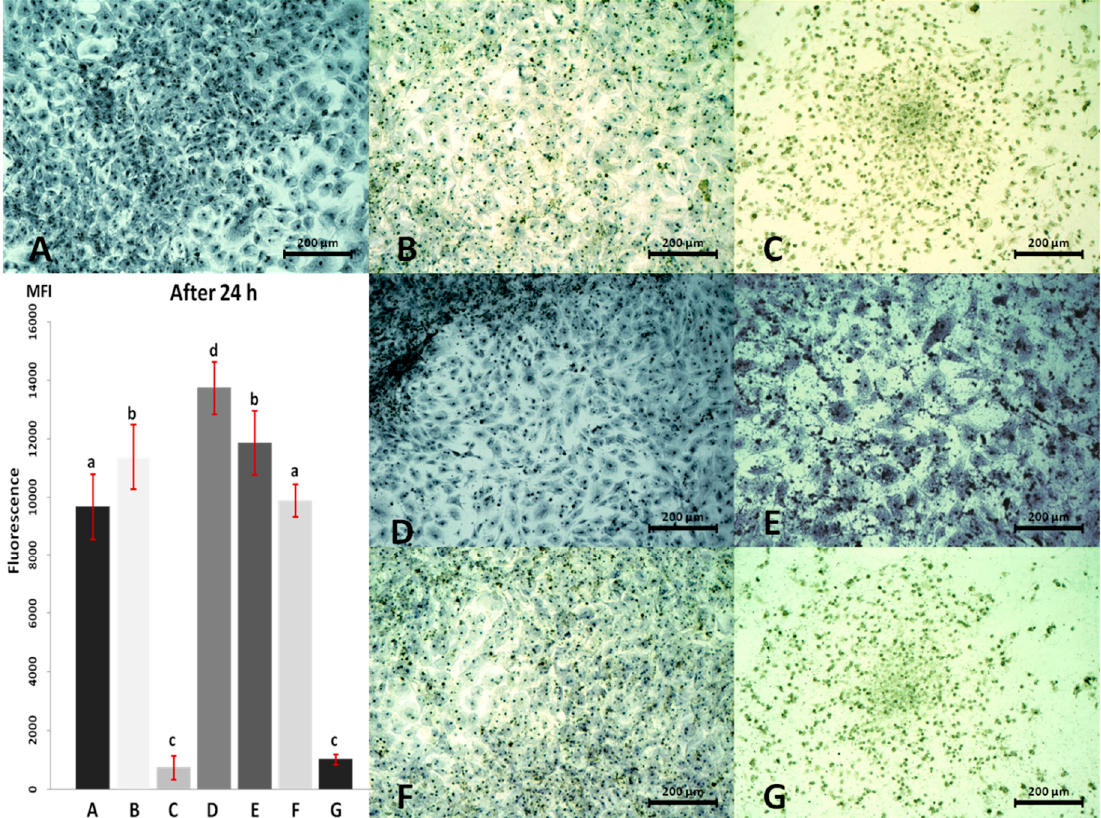
Figure 4. Cardiac progenitor cell morphology and viability after 24 h of culture with AgNP and HNC; ( A ) control culture; ( B ) culture with 2 μ g/mL AgNP; ( C ) culture with 10 μ g/mL AgNP; ( D ) culture with 0.4 μ g/mL HNC; ( E ) culture with 2 μ g/mL HNC; ( F ) culture with 2 μ g/mL AgNP and 0.4 μ g/mL HNC; ( G ) culture with 10 μ g/mL AgNP and 2 μ g/mL HNC. ( A – G ) Series of viability in individual experimental groups measured as fluorescence. (a–d) Statistically significant differences ( p ≤ 0.05). Magnification 100×. Scale bars 200 μ m. MFI—mean fluorescence intensity.